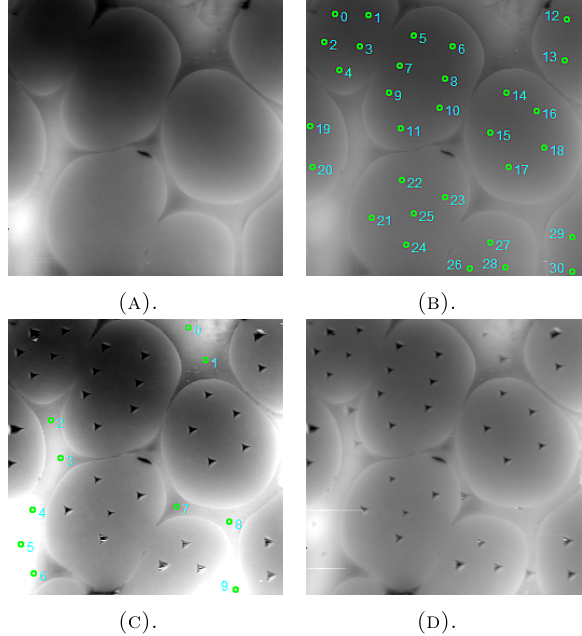
Figure 1. Indentation steps in longitudinal direction.